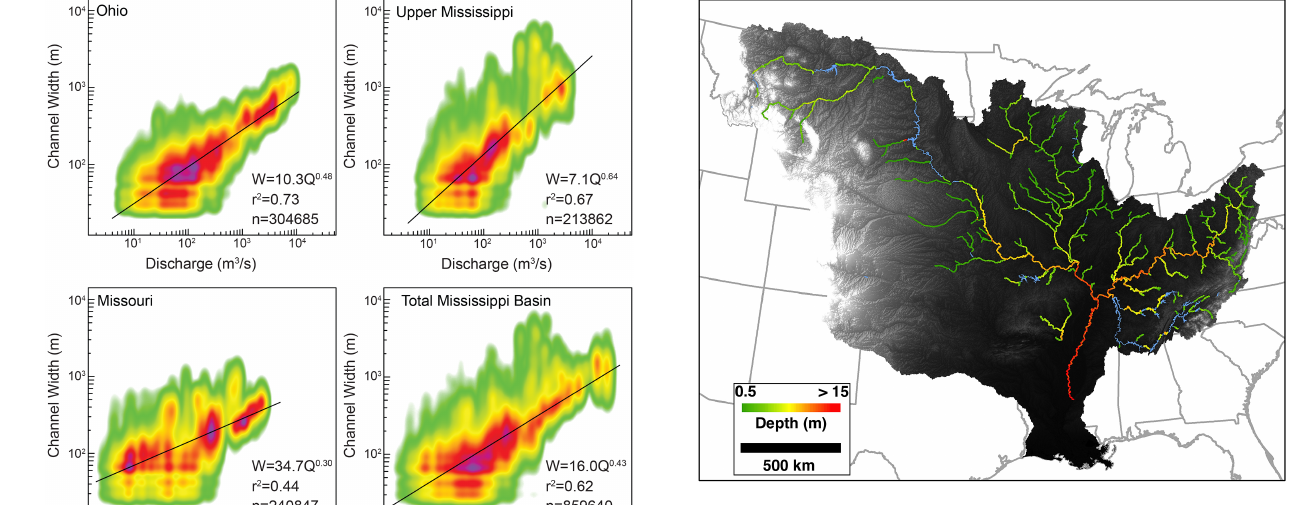
Figure 11. 8 × 10 5 mean depths in the Mississippi Basin estimated using multiple regression of d against Q and w ; lakes shown in